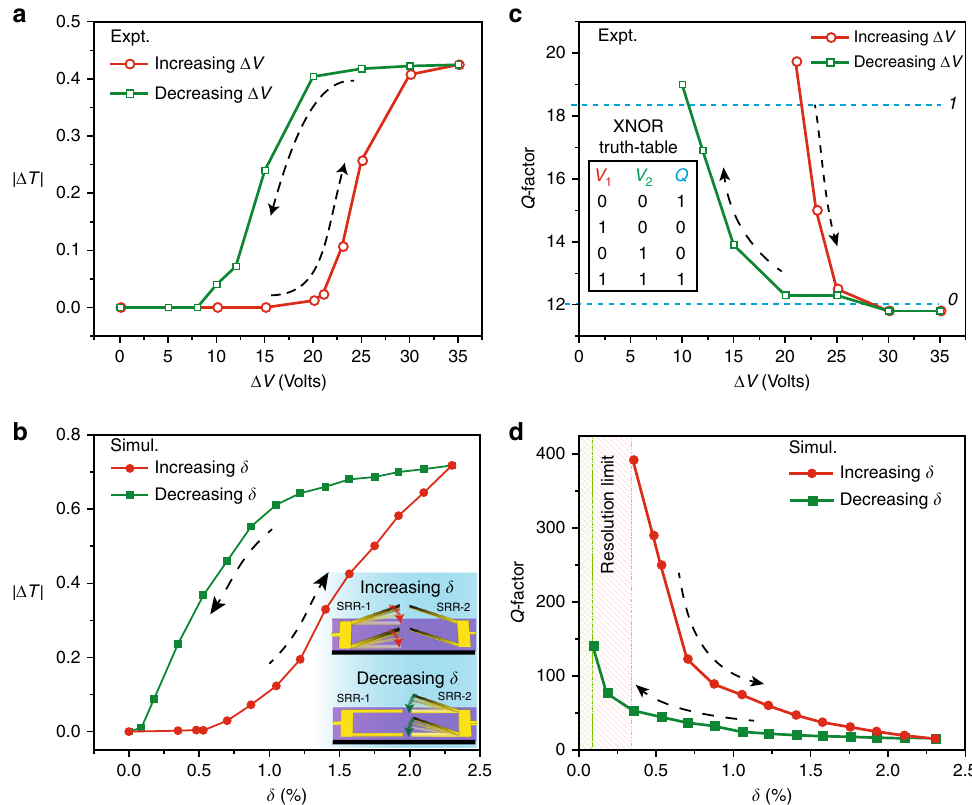
Fig. 3 Multiple-input – output electro-optical characteristics in the far- fi eld features of MEMS Fano-metasurface. a Measured Fano resonance transmission intensity (| Δ T |) with respect to differential voltage ( Δ V ) calculated for the curves shown in Fig. 2a and b, respectively. The red circles represent increasing order of Fano resonance strength by increasing the Δ V applied on the structures (applying V 1 on SRR-1 with V 2 = 0 V), whereas green squares represent decreasing state of Fano resonance in the presence of V 2 on SRR-2 with V 1 = 35 V that decreases the Δ V applied on the structure. b Simulated Fano resonance intensity (| Δ T |) showing two intensity states for a single asymmetry value ( δ ) of the system. The inset fi gure represents the sequential actuation of SRR-1 and SRR-2 that governs the observed multiple-input – output (MIO) states for the MEMS Fano-metasurface. c Experimentally and d numerically calculated Q -factors of the Fano resonance are shown that exhibits the MIO con fi guration for sequential actuation of the SRR-1 and SRR-2 resonators. Inset table in ( c ) represents the truth-table for the logic exclusive-NOR (XNOR) operation that can be visualized in the proposed MEMS Fano-metasurface device in the form of high ( ‘ 1 ’ ) and low ( ‘ 0 ’ ) values for Q -factors of Fano resonance in the far- fi